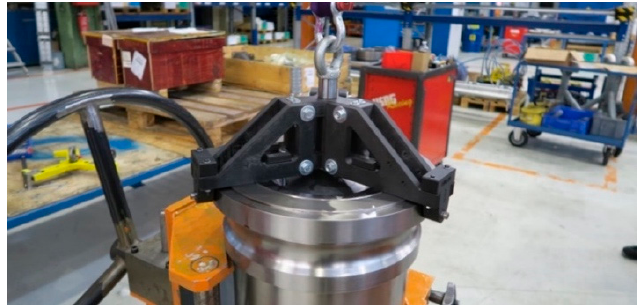
Figure 15. The mounting after successful certification was put into operation in Wärtsila workshops [42].